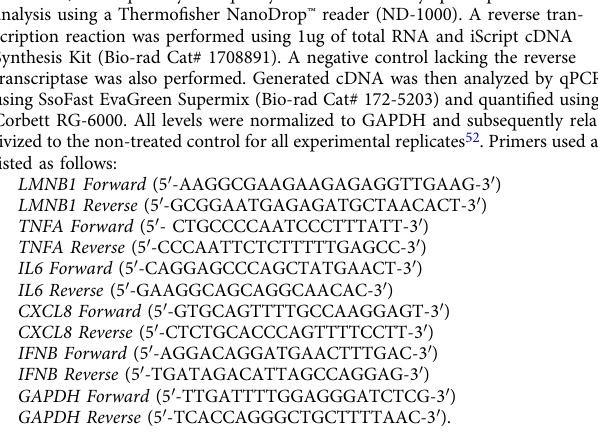
Fig. 5 The G3BP1 inhibitor, EGCG, recapitulates SASP inhibition associated with G3BP1 loss. a (left) Cell lysates from proliferative and 8-day post- ionizing radiation ( + IR) WI-38 cells treated or not with EGCG (40 μ M) were subjected to western blot analysis against indicated proteins. (right) Quanti fi cations represent a mean of relative protein levels from three independent experiments ± s.e.m (two-way ANOVA, Fisher ’ s LSD). b RNA was extracted from cells during proliferative stage (PRO) and 8-day post-ionizing radiation ( + IR) from WI-38 cells treated with or without (NT) increasing concentrations of EGCG (10, 20, and 40 μ M) and assayed by RT-qPCR using primers against the indicated mRNAs. The data are relative to PRO cells and are a mean of three independent experiments ± s.e.m (one-way ANOVA, Fisher ’ s LSD). c Conditioned media from proliferative (PRO) cells and 8-day post- ionizing radiation (SEN) WI-38 cells treated with or without 40 μ M EGCG. The heatmap indicates the fold change in comparison to the control PRO, SEN, and SEN treated with 40 μ M EGCG. Relative expression levels per replicate and average fold change differences are shown as indicated in heatmap. The data are representative of three independent experiments. d RNA was extracted from cells treated with siRNA targeting G3BP1 (siG3BP1) or scrambled control (siCTL) during proliferative stage (PRO) and 8-day post-ionizing radiation ( + IR) from WI-38 cells in the presence or absence (NT) of EGCG (40 μ M). RT-qPCR was then performed using primers against indicated mRNAs. The data are a mean of three independent experiments ± s.e.m (two-way ANOVA, Fisher ’ s LSD, exact <0.001 p -values from left to right: (top) 0.0001, 0.0001, 0.0001, 0.0011, (bottom) 0.0001, 0.0001, 0.0001, 0.0004, 0.0001, 0.0001). Source Data for panels ( a ), ( b ), and ( d ) are provided in the Source Data File. Raw data for ( c ) is provided in Supplementary